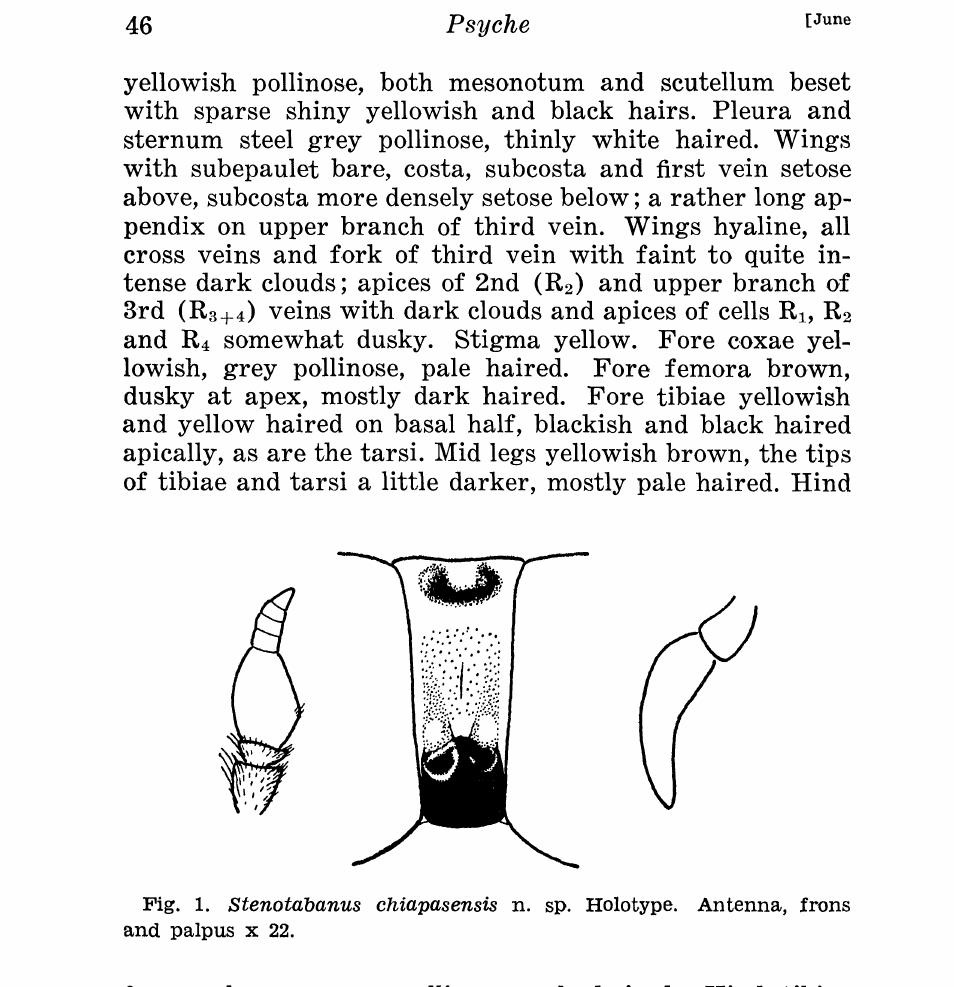
Fig. 1. Stenotabanus chiapasensis n. sp. ttolotype. Antenna, Irons nd palpus x